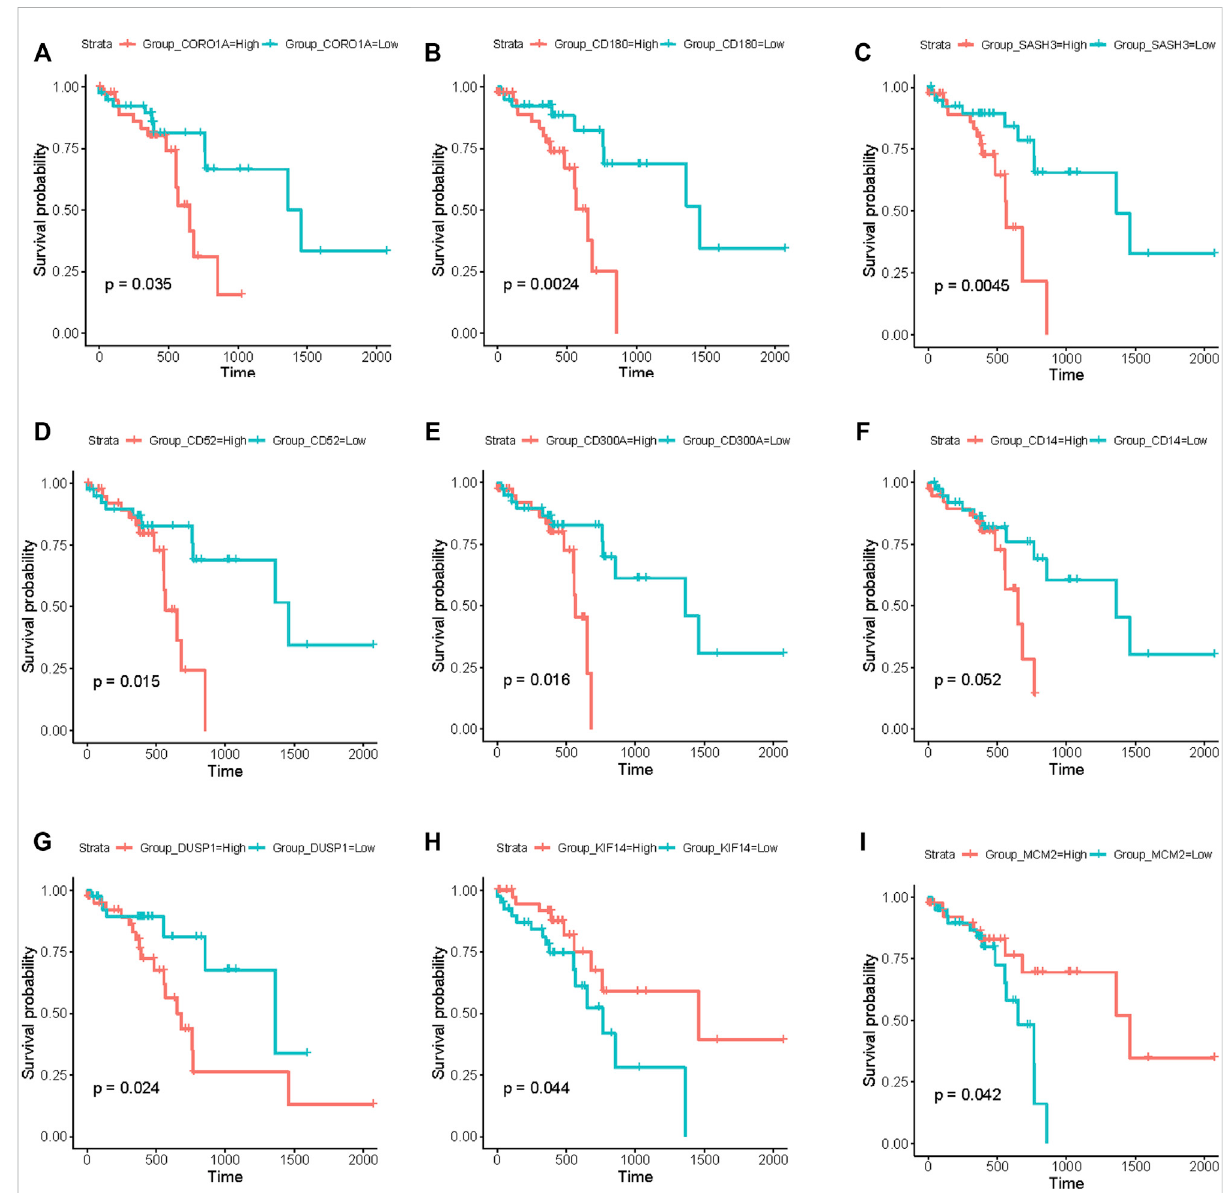
FIGURE 6 Survival analysis using the RNA-seq data from TCGA database. (A – I) Kaplan – Meier curves showing that the expression levels of these nine genes (CORO1A, CD180, SASH3, CD52, CD300A, CD14, DUSP1, KIF14, and MCM2) were signi fi cantly associated with survival of patients with